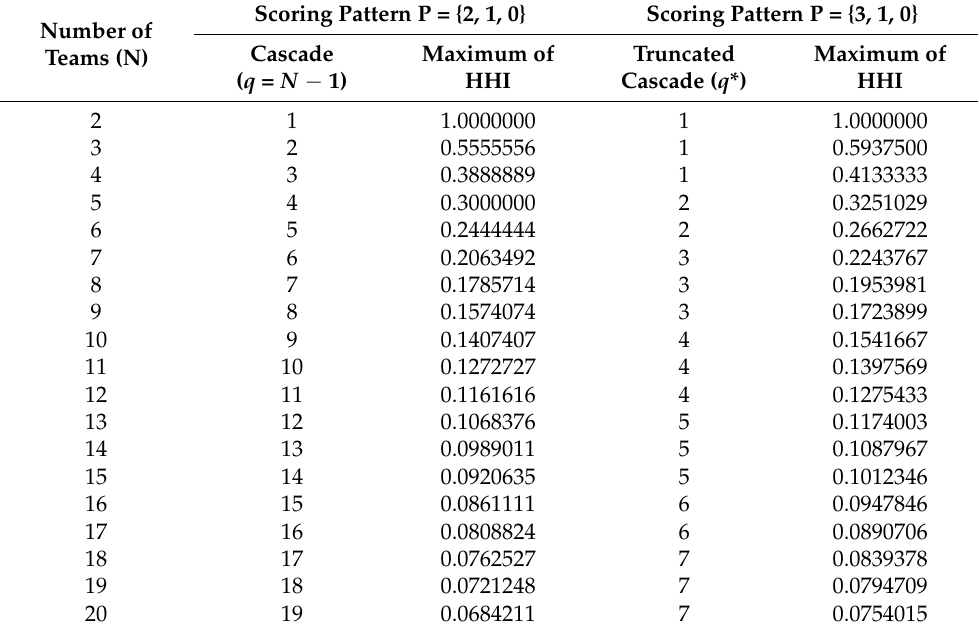
Table 2. Least-balanced distributions for different numbers of teams and scoring